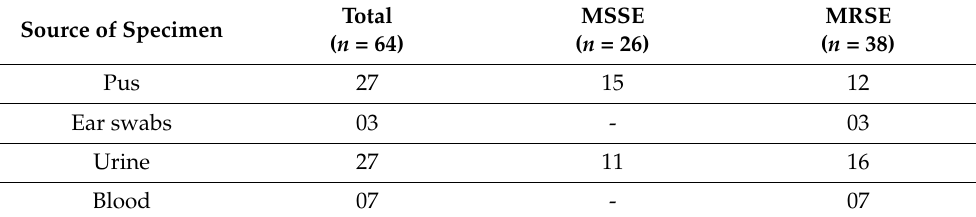
Table 1. Distribution of MRSE and MSSE based on clinical specimens. Source of Specimen